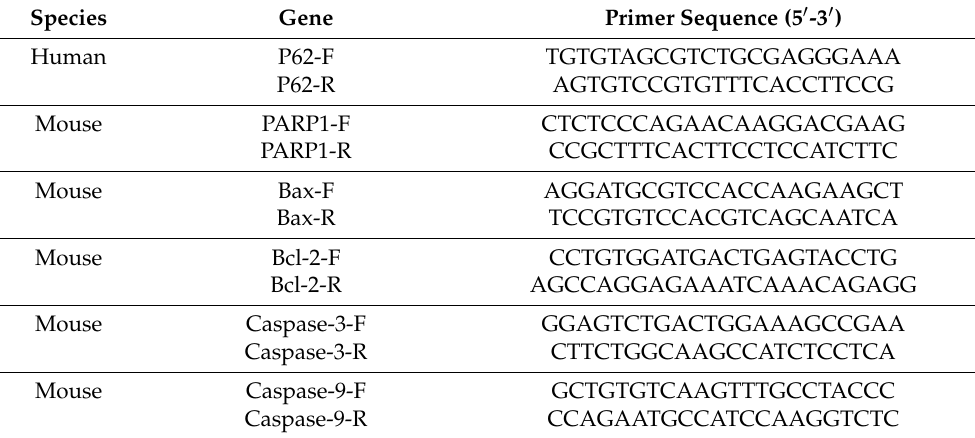
Table 1. Cont . Species Gene Primer Sequence (5 (cid:48) -3 (cid:48)